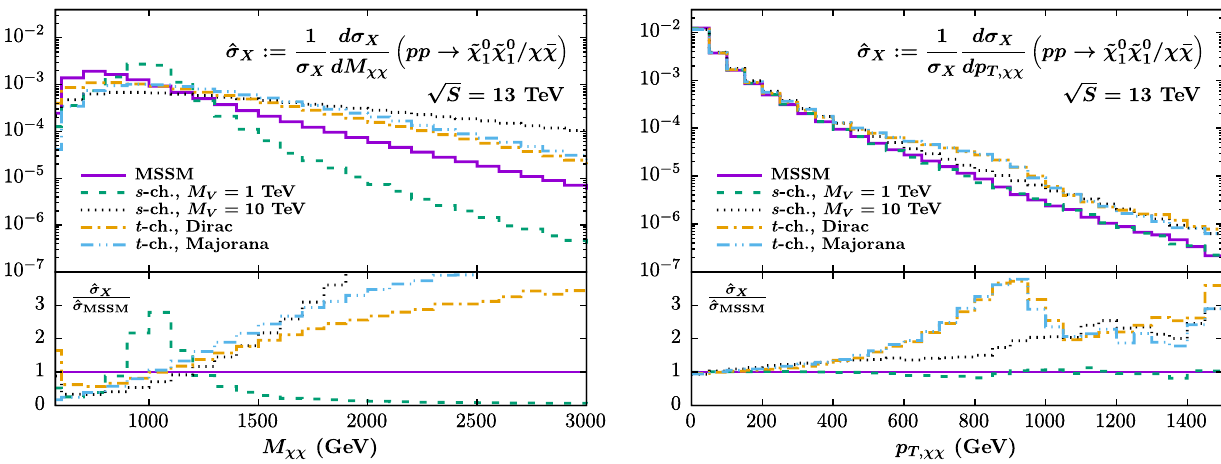
Fig. 12 Invariant mass (left) and the transverse momentum distribution (right) of the DM pair system at NLO+PS accuracy. Masses and parameters are chosen according to the ˜ h / ˜ b parameter point of Fig. 7. The coloring of the lines follows the scheme introduced in Fig.